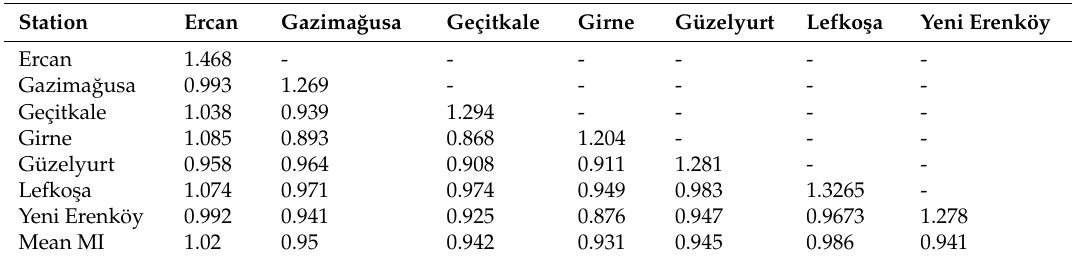
Table 3. The mutual information (MI) between the observed precipitation time series of